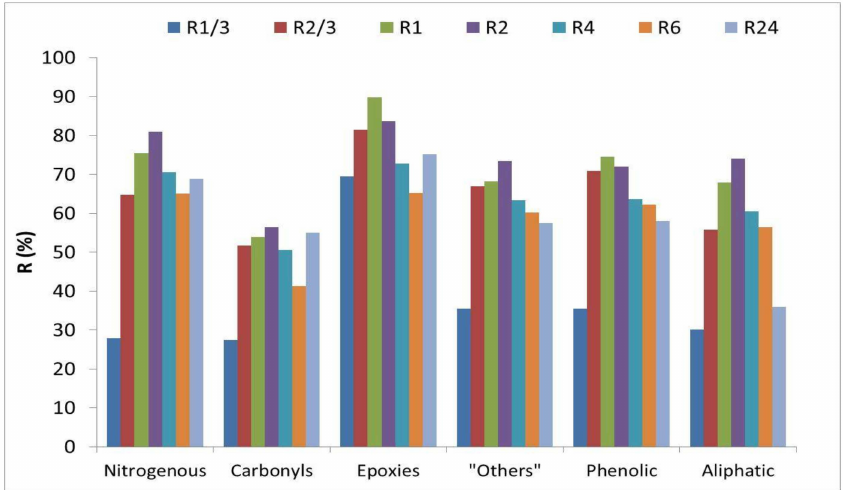
Figure 14. Reductions of the groups of compounds considered in the condensed fraction vs. reaction